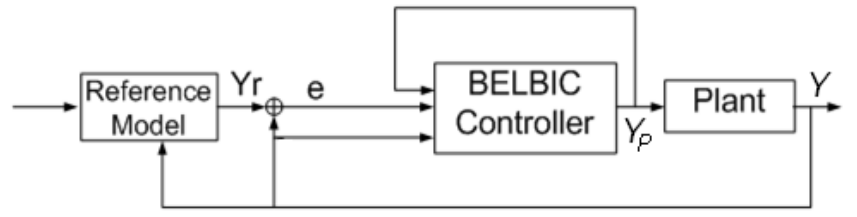
Figure 8. General outline of the emotional controller function, adopted from [22].